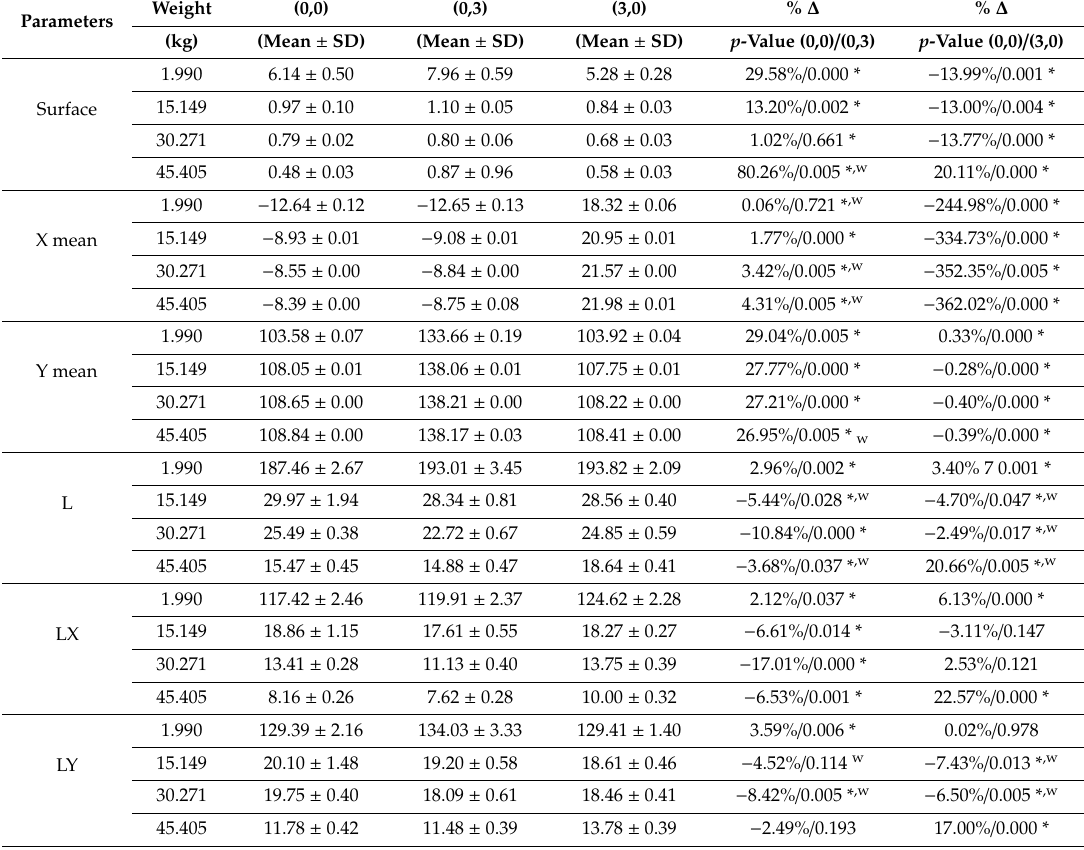
Table 1. Results of force platform Satel validation by parameters Surface, X mean, Y mean, Length (L), Length on x-axis (LX), Length on y-axis (LY).